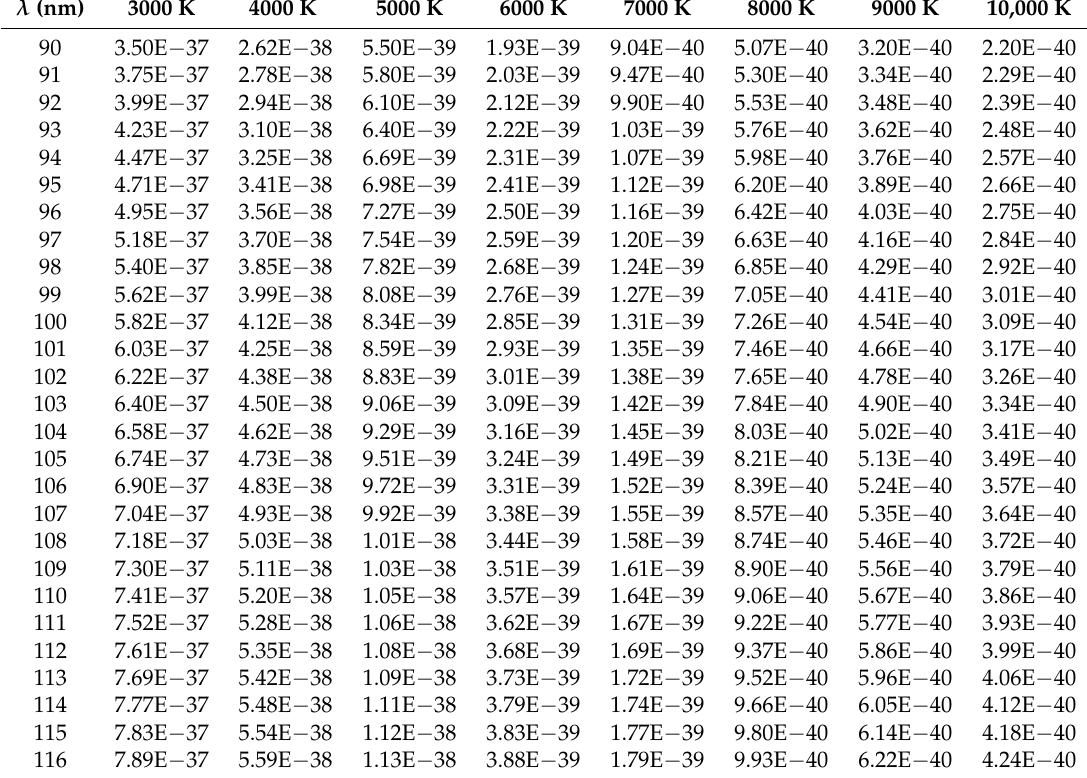
Table 1. The coefficient K ia ( cm 5 ) Equation (9) as a function of λ and T